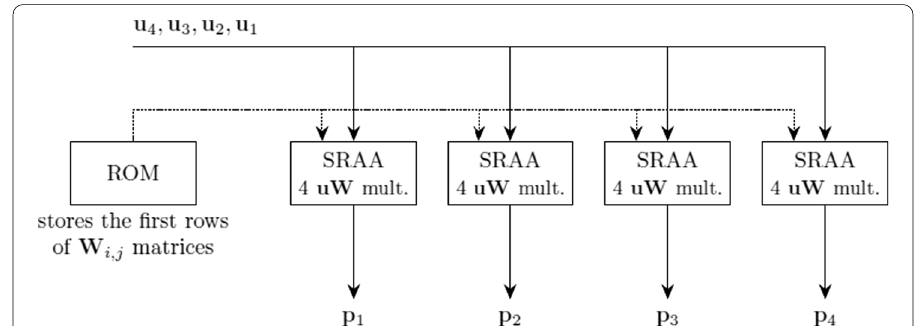
Fig. 13 SRAA complete